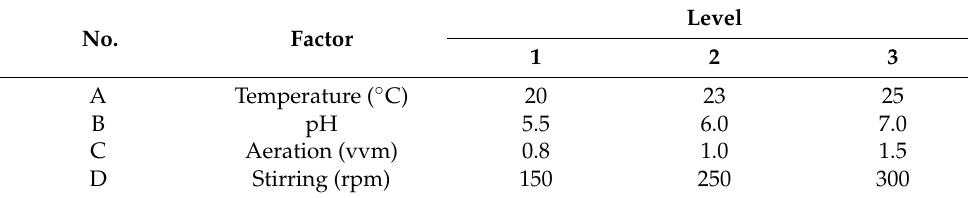
Table 8. The controlled factors and their assigned